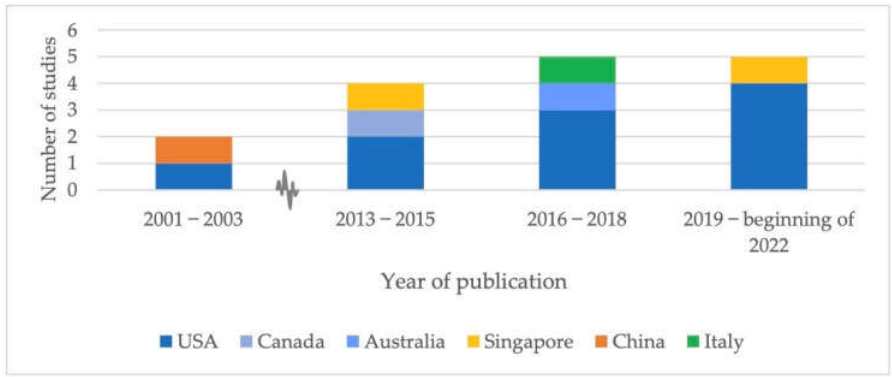
Figure 2. Numbers of included studies by year and country of origin.